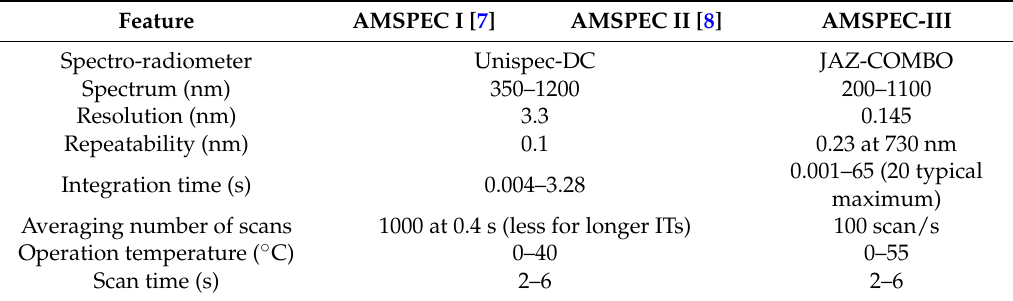
Table 1. Technical specifications of the third generation Automated Multiangular SPectro-radiometer for Estimation of Canopy reflectance system (AMSPEC-III).